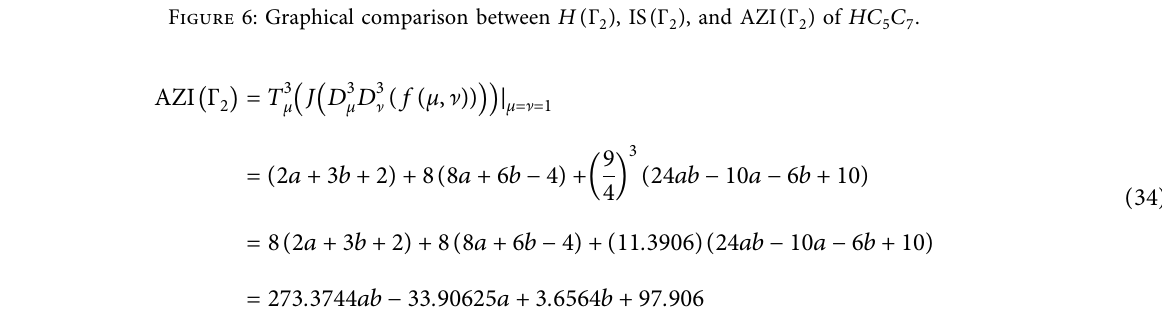
Figure 6: Graphical comparison between H ( Γ